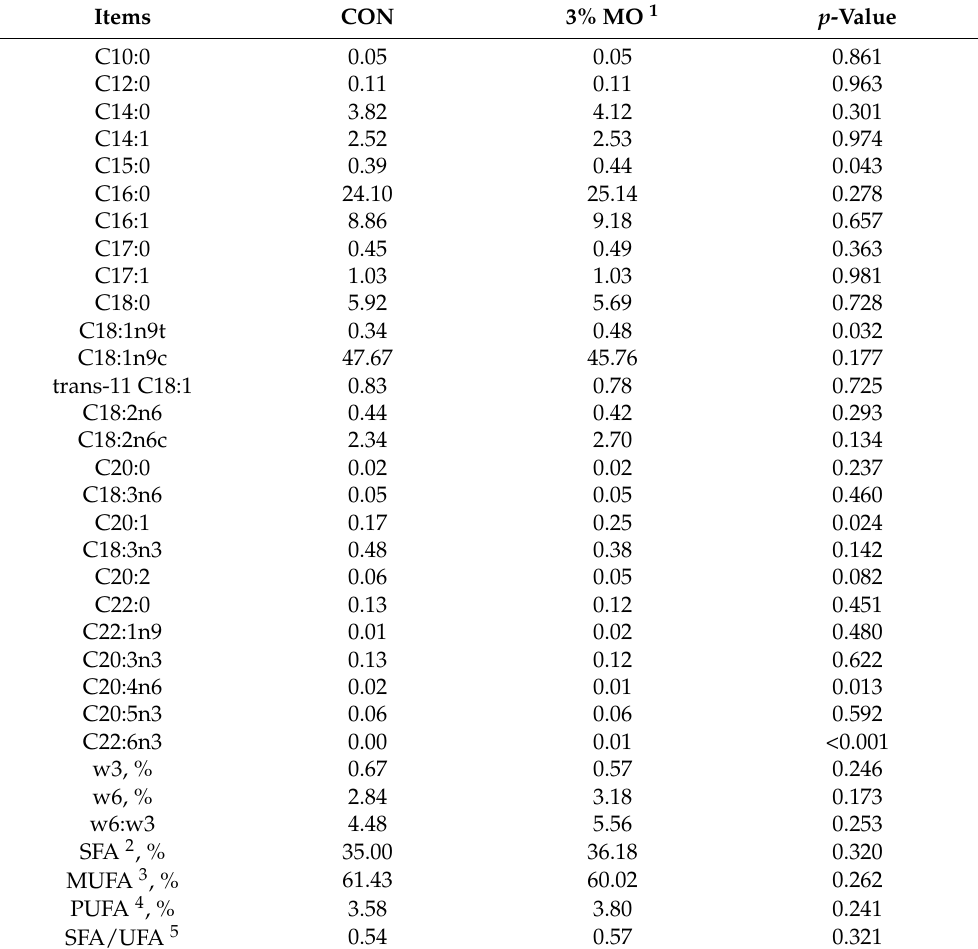
Table 7. Effect of a 3% rumen-protected microencapsulated supplement (MO) on the fatty acid composition (%) of subcutaneous fat in